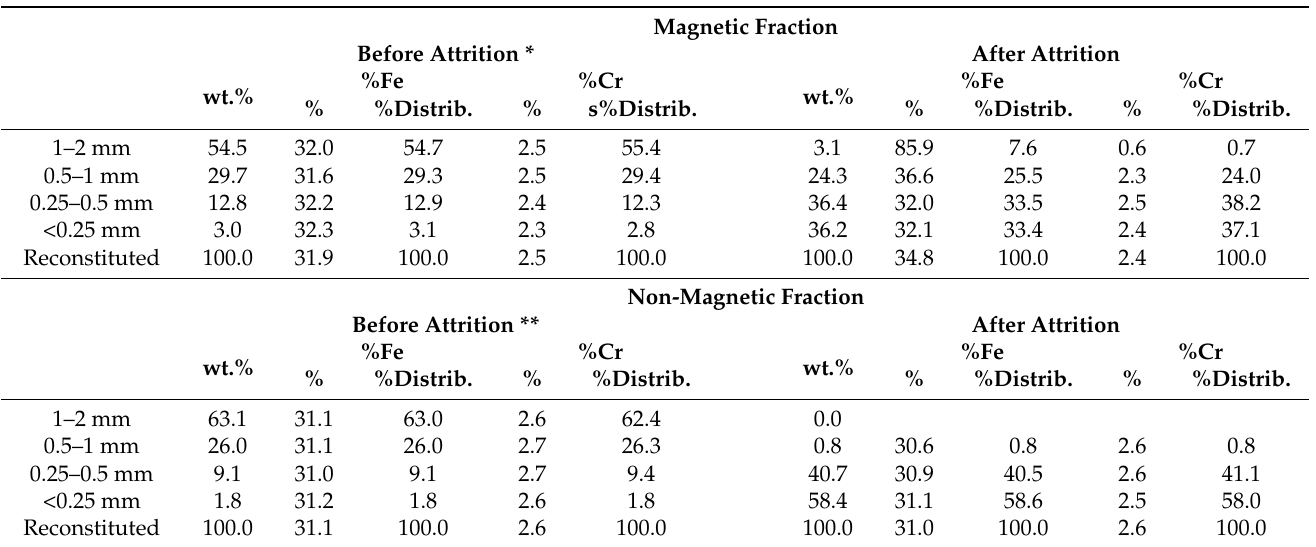
Table 4. Mass balance of the attrition step performed during 40 min on the magnetic and non- magnetic fractions.